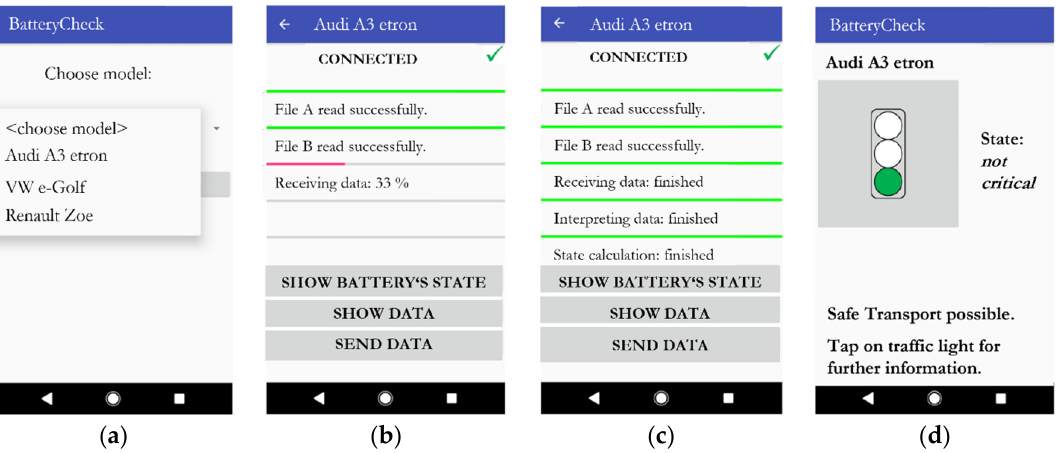
Figure 5. User interface of the app “BatteryCheck” (selected example model: Audi A3 e-tron): ( a ) initial view with available models; ( b ) view while receiving data from the BMS; ( c ) view after successful reception and evaluation of data; ( d ) display of calculated safety-state result with additional information.